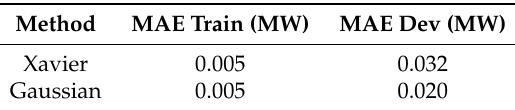
Table 2. Comparison of initialization methods for the statistical learning model for inflow from 330 ± 5 ◦ for all wind speeds in the dataset. The statistical learning model is initialized with the Xavier [69] and the Gaussian (Equation (13))